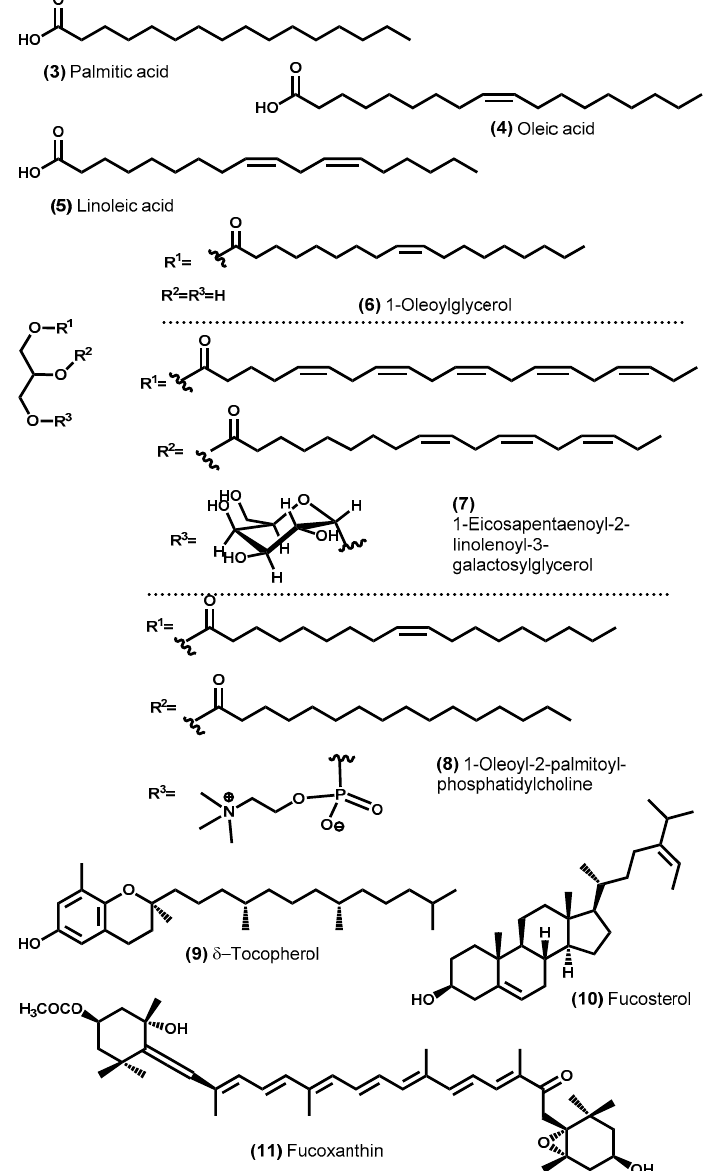
Figure 2. Chemical structure of some examples of saturated and unsaturated fatty acids ( 3 – 5 ), acylglycerols ( 6 ), glycoglycerolipid ( 7 ), phospholipids ( 8 ), lipophilic vitamin ( 9 ), sterol ( 10 ), and carotenoid ( 11 ) identified in seaweeds [48,119,120].